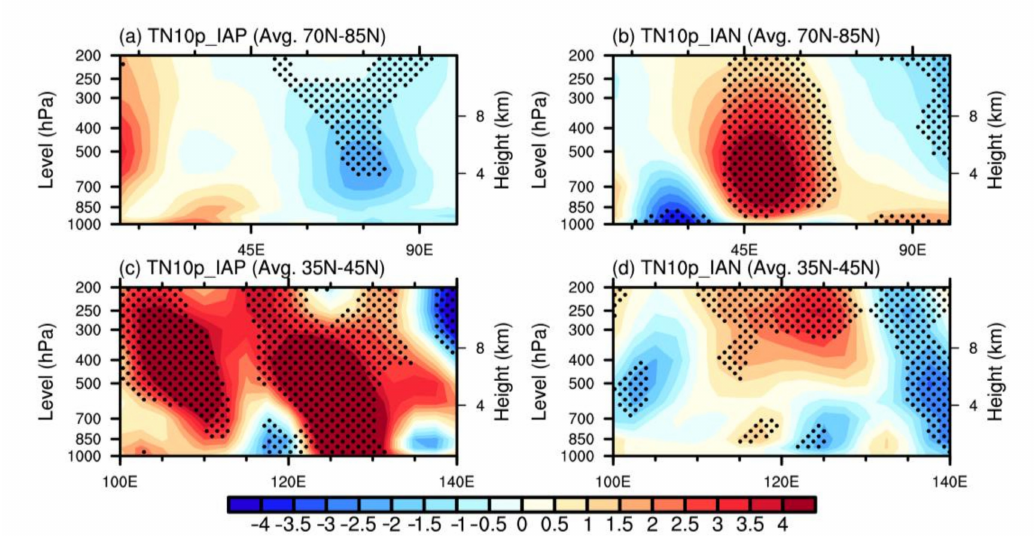
Figure 8. Vertical velocity anomaly (shaded, unit: 10 − 3 Pa s − 1 ) in averaged over Barents-Kara Seas (70 ◦ N–85 ◦ N) in ( a ) TN10p_IAP years and ( b ) TN10p_IAN years. ( c , d ) is the same as ( a , b ), but for NEC (35 ◦ N–45 ◦ N). The dotted region indicates significance at the 90% level from the t